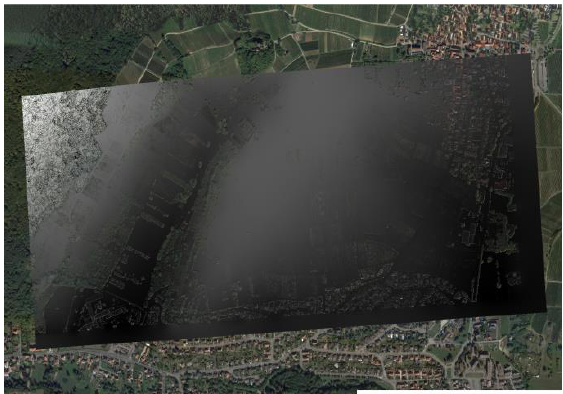
Figure 6. The DTM of the entire study with the cut off areas that represent buildings and higher vegetation. The grey values represent the DTM while all colored areas are from the ortho- photo underlying this data set